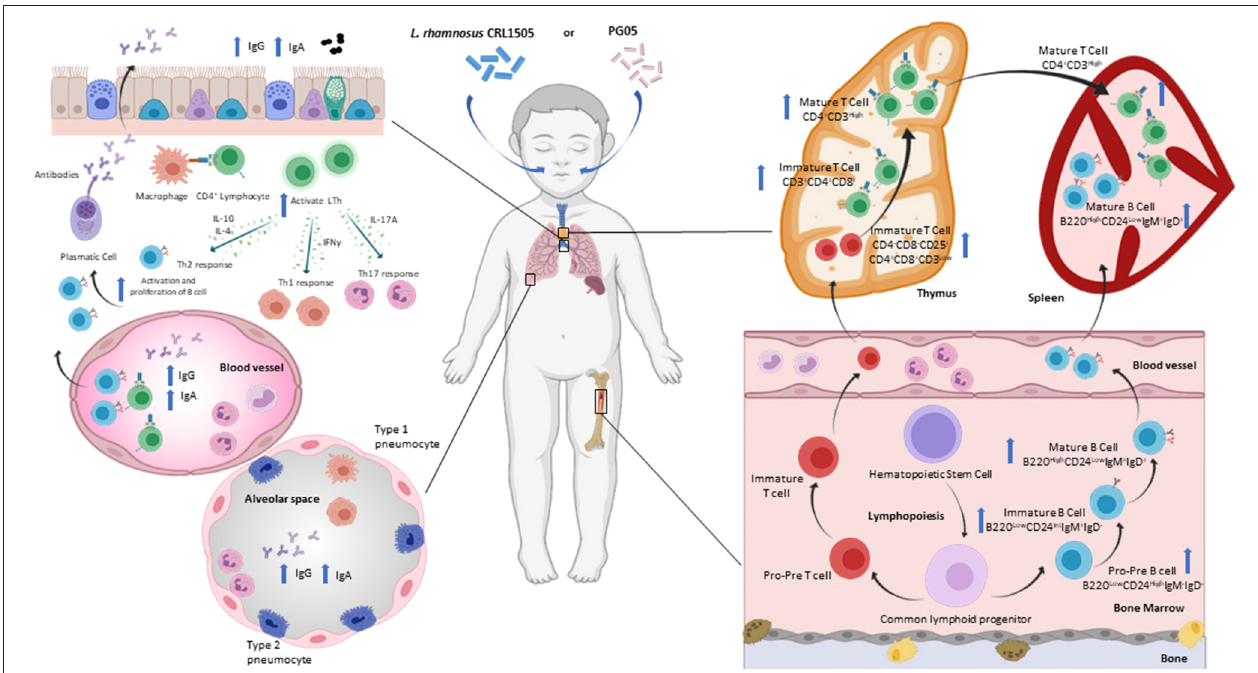
FIGURE 3 | Modulation of respiratory specific immunity by immunobiotic or postbiotic nasal treatments in malnourished host. Proposed mechanism for the distal immunomodulation induced by the immunobiotic strain Lactobacillus rhamnosus CRL1505 or its peptidoglycan on the resistance against Streptococcus pneumoniae infection, maturation and differentiation of T and B cells in bone marrow, spleen, thymus and lung (Figure created with Biorender.com).